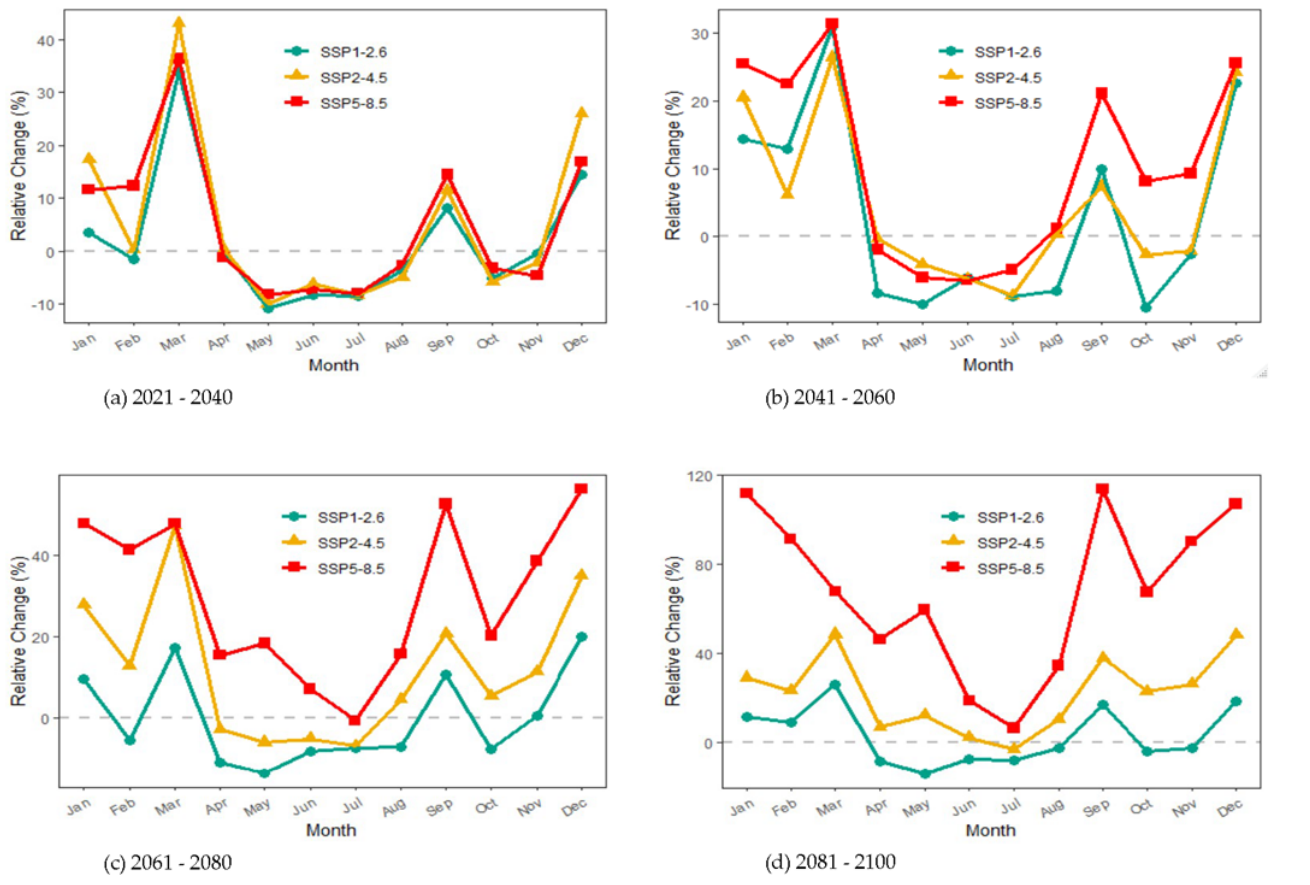
Figure 8. Predicted monthly change (%) in rainfall erosivity at Magna for the periods 2021–2040, 2041–2060, 2061–2081 and 2081–2100, compared to the baseline period of